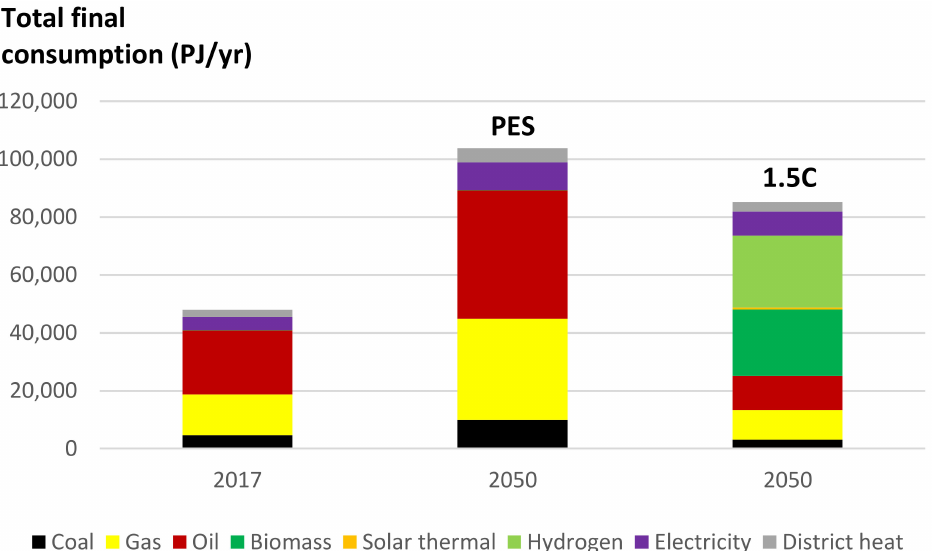
Figure 4. Breakdown of the estimated total final consumption of the global chemical and petrochemi- cal sector by energy carrier, 2017 and